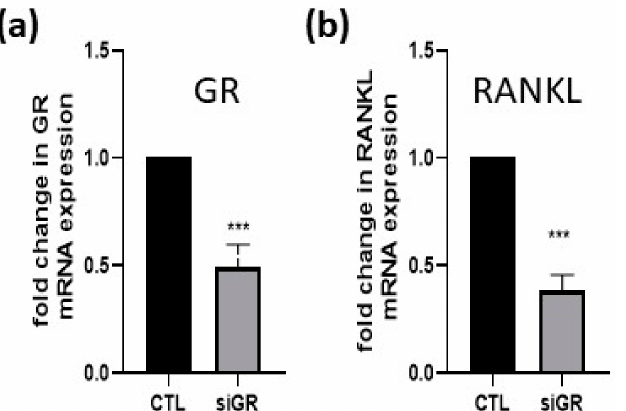
Figure 6. Silencing of NR3C1 in HOS downregulated RANKL expression. ( a ) HOS cells were transfected with siGR or control siRNA (siCTL) and 72 h after transfection RNA was isolated and level of GR mRNA measured by quantitative PCR. ( b ) HOS cells were transfected with siGR or control siRNA (siCTL) and 72 h after transfection RNA was isolated and level of RANKL mRNA measured by quantitative PCR. All of the data are presented as mean relative gene expressions after normalization with GAPDH expression. Expression in control siCTL samples is set to 1. The results are expressed as the mean ± SEM. ***– p <